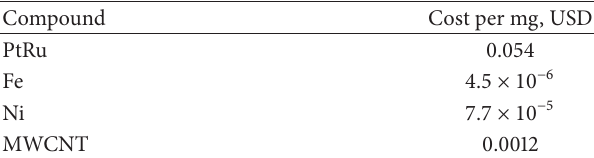
Table 6: List of current